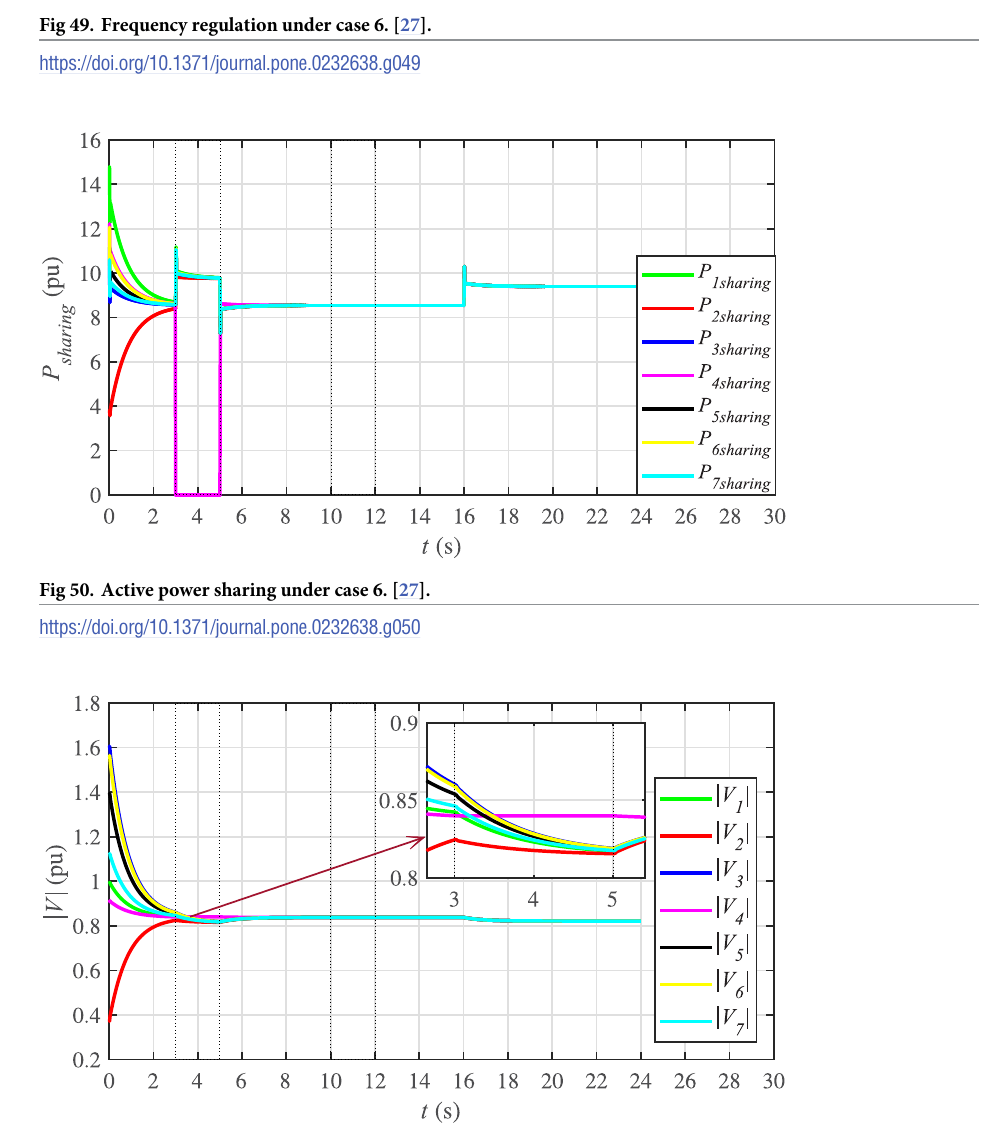
Fig 51. Voltage regulation under case 6. [27].